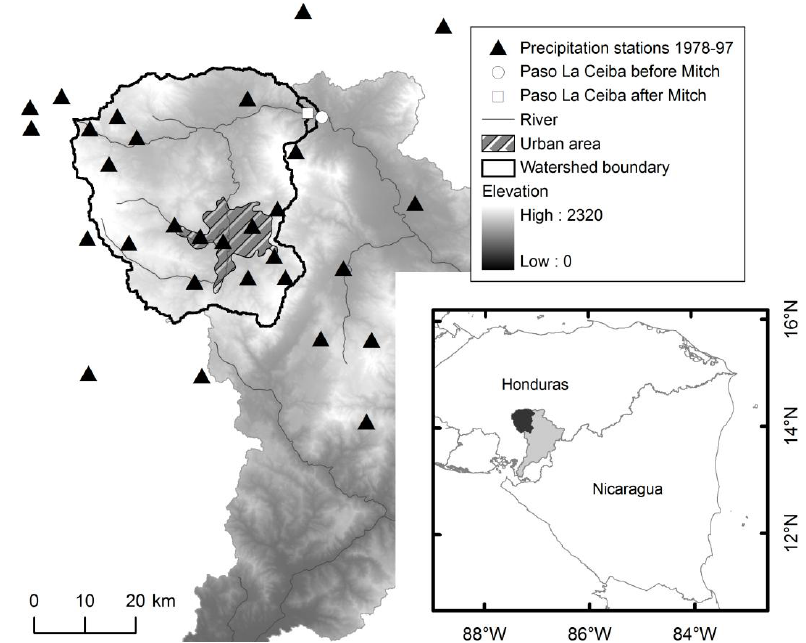
Fig. 1. The Choluteca River Basin and the Paso La Ceiba catchment, the urban area in the upper catchment represents Tegucigalpa, the Honduran capital. Black triangles represent precipitation stations with daily data in 1978–1997 within 30km of the Paso La Ceiba catchment.